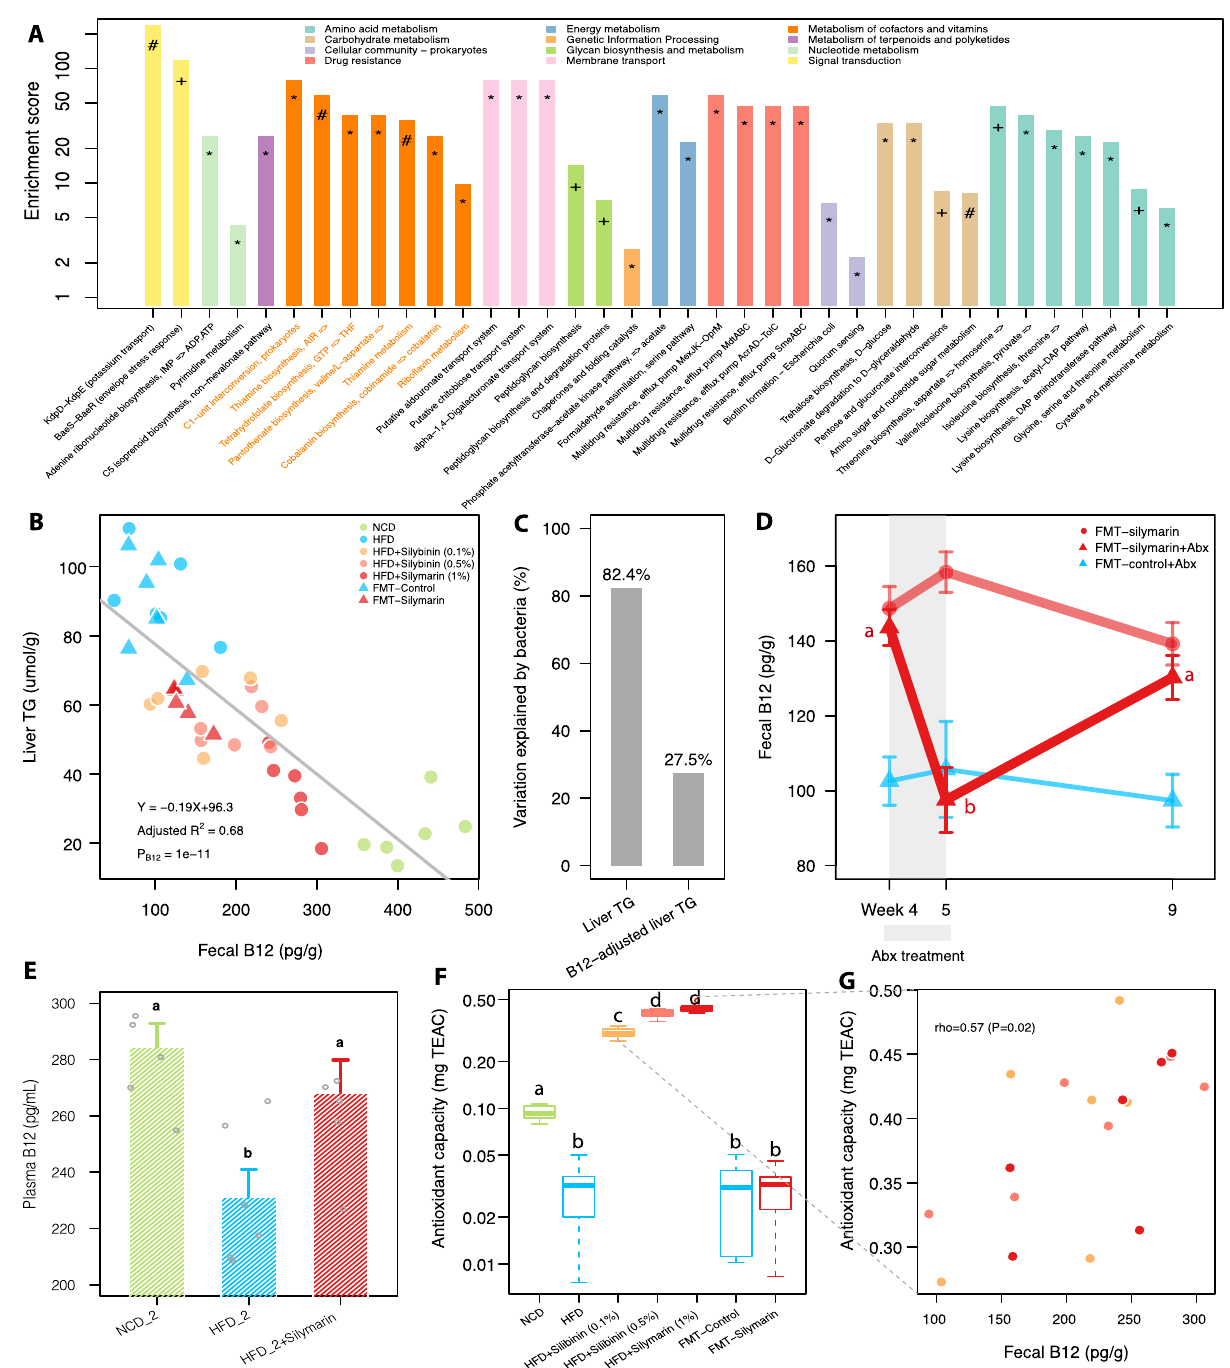
Fig. 4 | Microbial functional alternations upon silymarin treatment. A Pathway enrichment analysis for those 110 KOs that were mostly (spearman correlation coef fi cient rho ≥ 0.9 or ≤− 0.9) associated with liver TG; hypergeometric test was used for analysis (*, +, and # indicate adjusted P <0.05, 0.01, and 0.001, respec- tively). B Linear regression analysis between fecal B12 concentrations and liver TG levels. C Bar plot showing the variations of raw liver TG and liver TG adjusted for fecal B12 explained by the gut bacteria based on random forest regression; the levels of liver TG adjusted for B12 were measured by the residuals calculated from thelinearregressionbetweenliverTGandfecalB12inpanel( B ). D Thelongitudinal changesoffecalB12duringfecalmicrobiotatransplantation(FMT)withorwithout